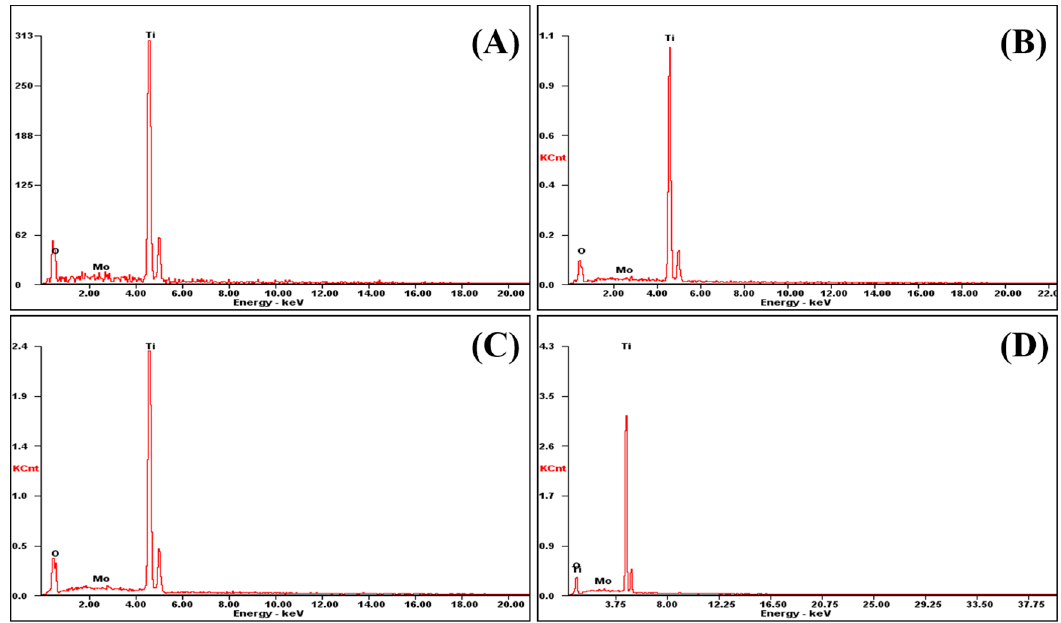
Figure 5. EDS spectra of Mo-TiO 2 nanotube array films with nominal Mo-doped concentration of ( A ) 1.0%, ( B ) 0.50%, ( C ) 0.25% and ( D ) 0%.